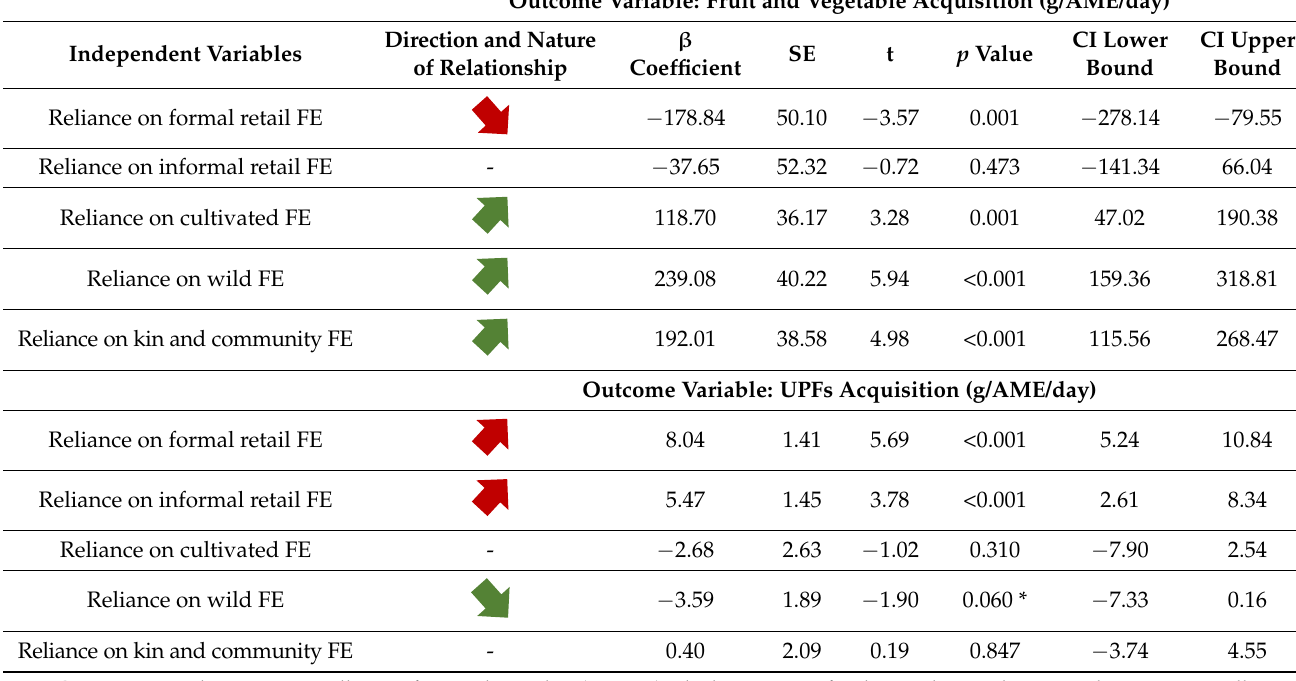
Green arrow indicates statistically significant relationship ( p < 0.05) which is positive for diet quality. Red arrow indicates statistically significant relationship ( p < 0.05) which is negative for diet quality. Full regression model available in Supplementary Material Table S6. FE, food environment. SE, standard error. CI, confidence interval. AME, adult male equivalent. UPF, ultra-processed food. * p -value for log-transformed outcome variable was p = 0.008.